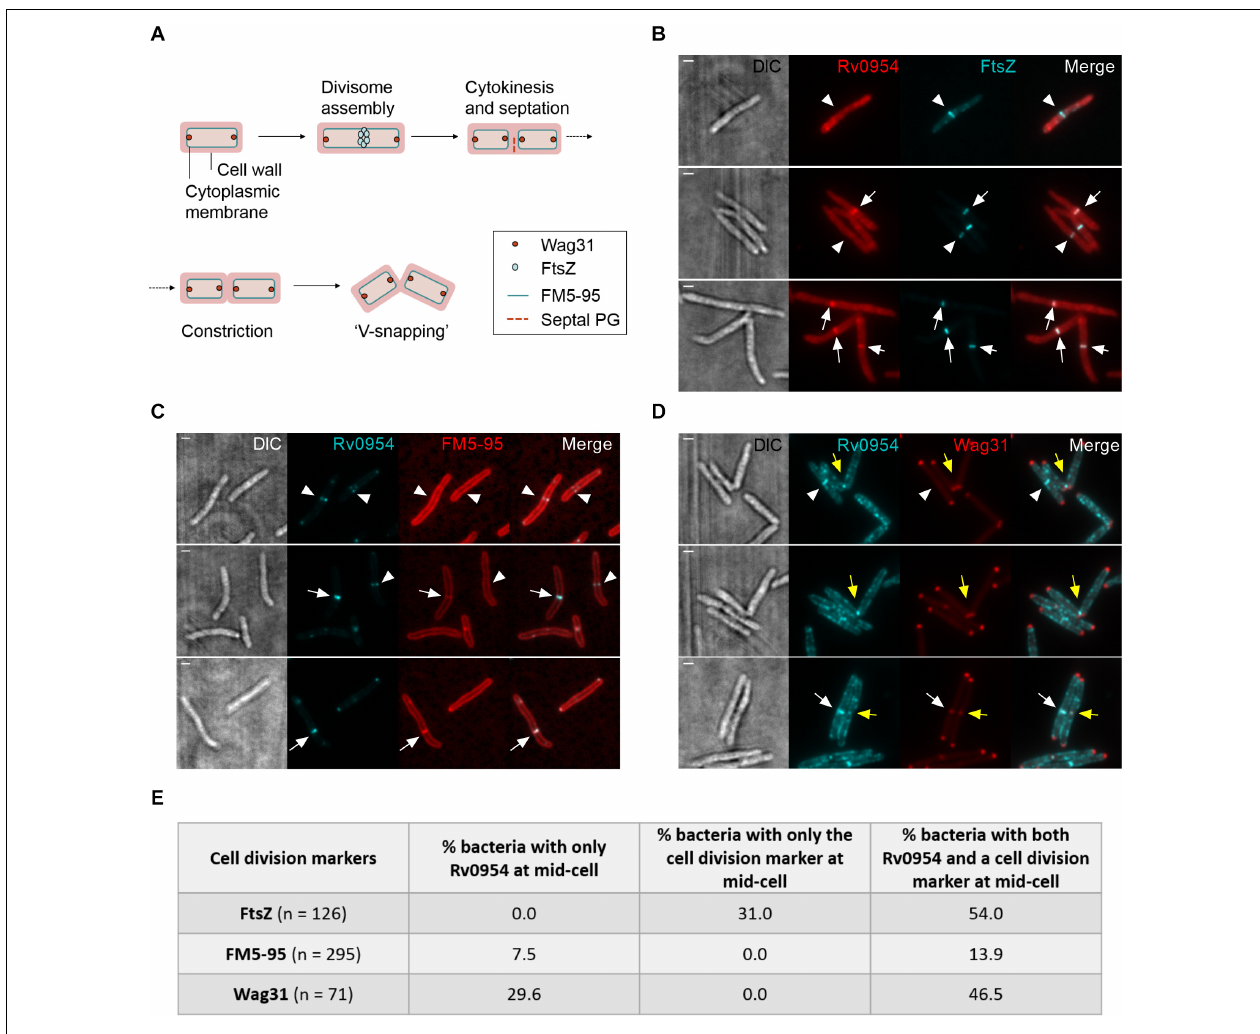
FIGURE 2 | Mid-cell localization of Rv0954 relative to markers of cell division events. (A) Schematic of division markers in different stages of cell division. (B–D) Representative microscopy images of replicating Msm expressing (B) FtsZ msm -GFP and Rv0954-mCherry (C) Rv0954-GFP (D) Rv0954-GFP and Wag31 mtb -mCherry constitutively. (B) Arrowheads point to the presence of FtsZ signals and the absence of Rv0954 signals at the mid-cell. Arrows point to the colocalization of FtsZ and Rv0954. (C) Replicating Msm stained with FM5-95 to label the cytoplasmic membrane. Arrowheads point to the presence of Rv0954 signals and the absence of septal FM5-95 staining. Arrows point to the overlapping of Rv0954 and FM5-95 signals at the mid-cell. (D) White arrowheads point to the presence of Rv0954 and the absence of Wag31 mtb at the mid-cell. White arrows point to the mid-cell localization of both Rv0954 and Wag31 mtb . Yellow arrows point to Msm undergoing constriction. Scale bar, 1 µ m. (E) Quantification of bacteria with Rv0954 and respective cell division markers at mid-cell. N indicates the number of bacteria